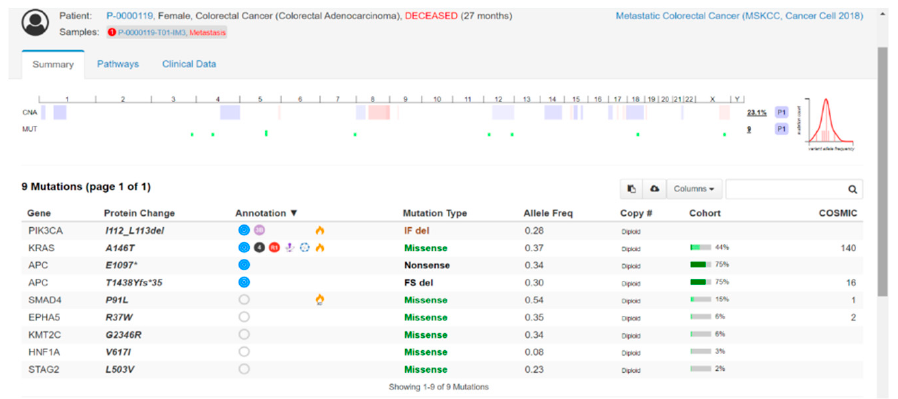
Figure 2. Patients’ distribution by age.